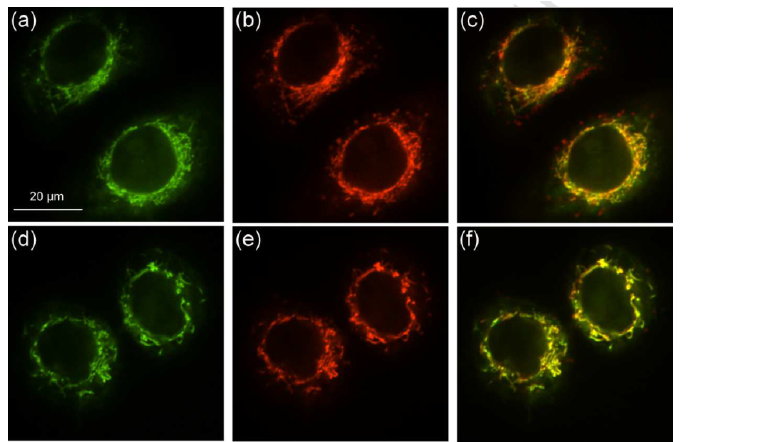
Figure 15. Confocal fluorescence imaging of SGC-7901 cells stained with 18b and 18c . ( a ) 18b fluorescence (488 nm), ( b ) MitoTracker Red fluorescence (561 nm), and ( c ) merged images. ( d ) MitoTracker Green fluorescence (488 nm), ( e ) 18c fluorescence (561 nm), and ( f ) merged images. Adapted from [46].